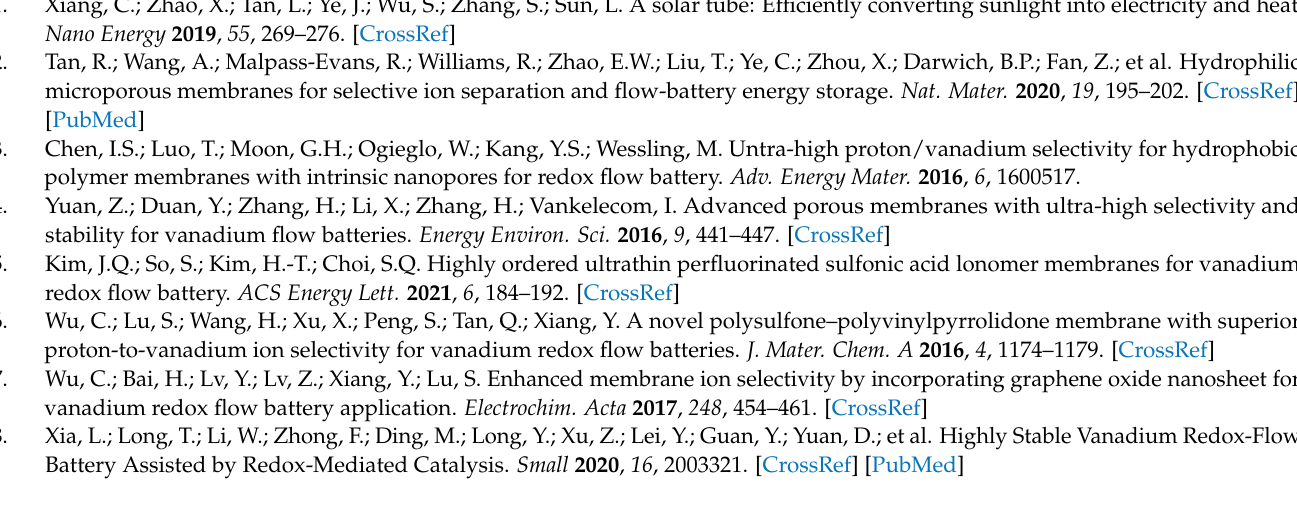
Figure S6: The Nyquist plots for the cells with different